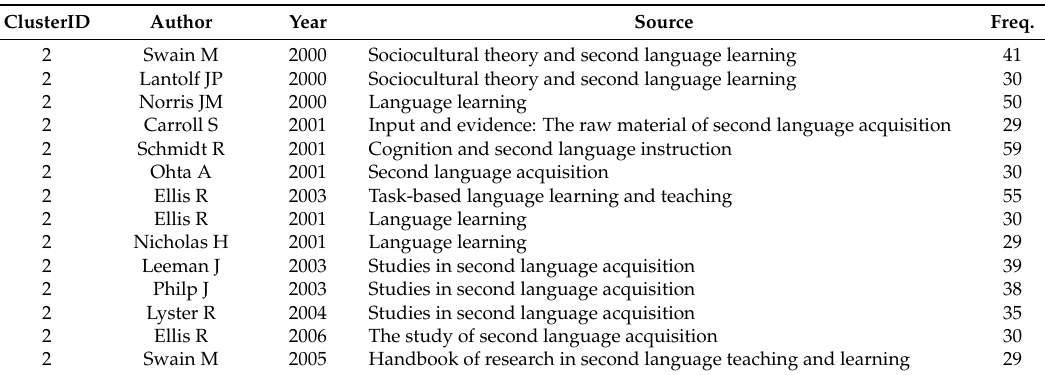
Table 4. The members of Cluster